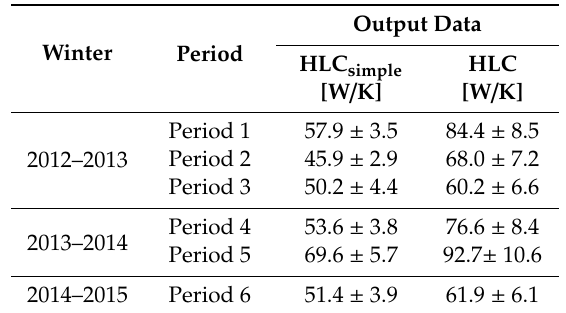
Table 4. The HLC simple (simple Heat Loss Coe ffi cient) and HLC (Heat Loss Coe ffi cient) estimated values for Gainsborough.